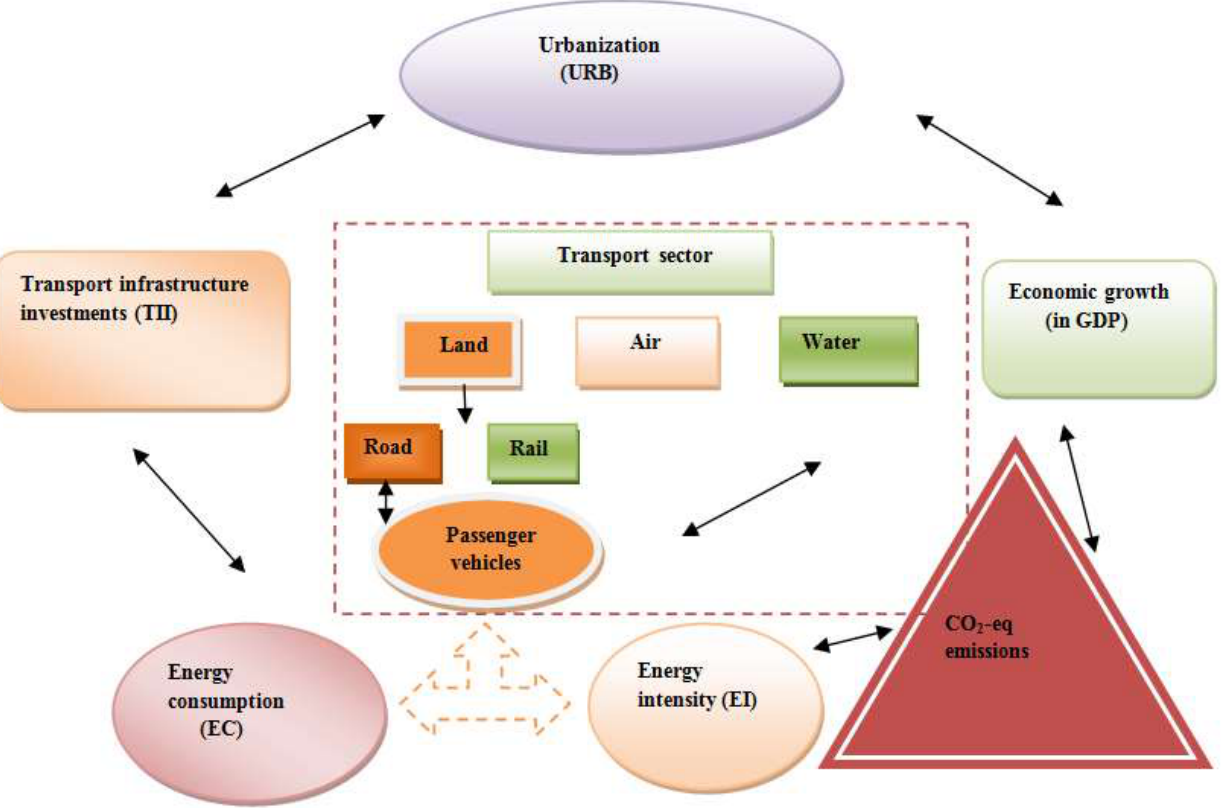
Figure 1. Descriptive directional links among CO 2 -eq and the exogenous variables in the transport sector.